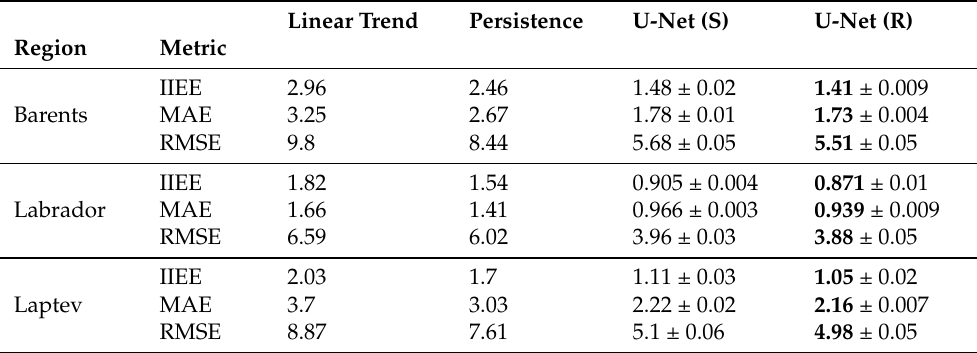
Table 4. JAXA SIC metrics averaged over 3 forecast days and over 2021 for baselines and our best U-Net configurations (general with GFS). IIEE is computed for SIC classes with a 15% binarization threshold. For the models, we report mean and unbiased std of 3 independent runs with random seeds 0, 1, and 2. The best mean value in the each row is printed in bold. Linear Trend Persistence U-Net (S) U-Net (R) Region Metric Barents